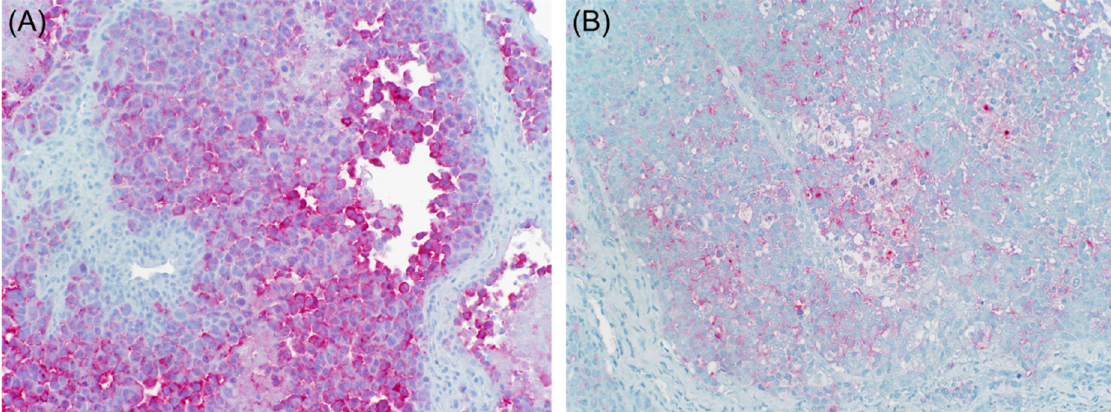
Figure 6. Malignant melanoma. Lesional cells are positive for Mart-1 (( A ), immunohistochemical stain × 20) with aberrant expression of CEA ( B , immunohistochemical stain 20).